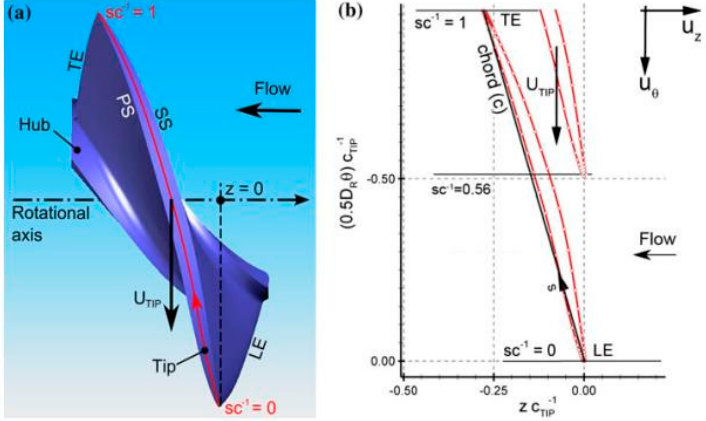
Figure 8. ( a ) Sketch of main components in impeller. ( b ) Tip profile curves [17]. s is a coordinate aligned with the blade chord and c is the chord length.